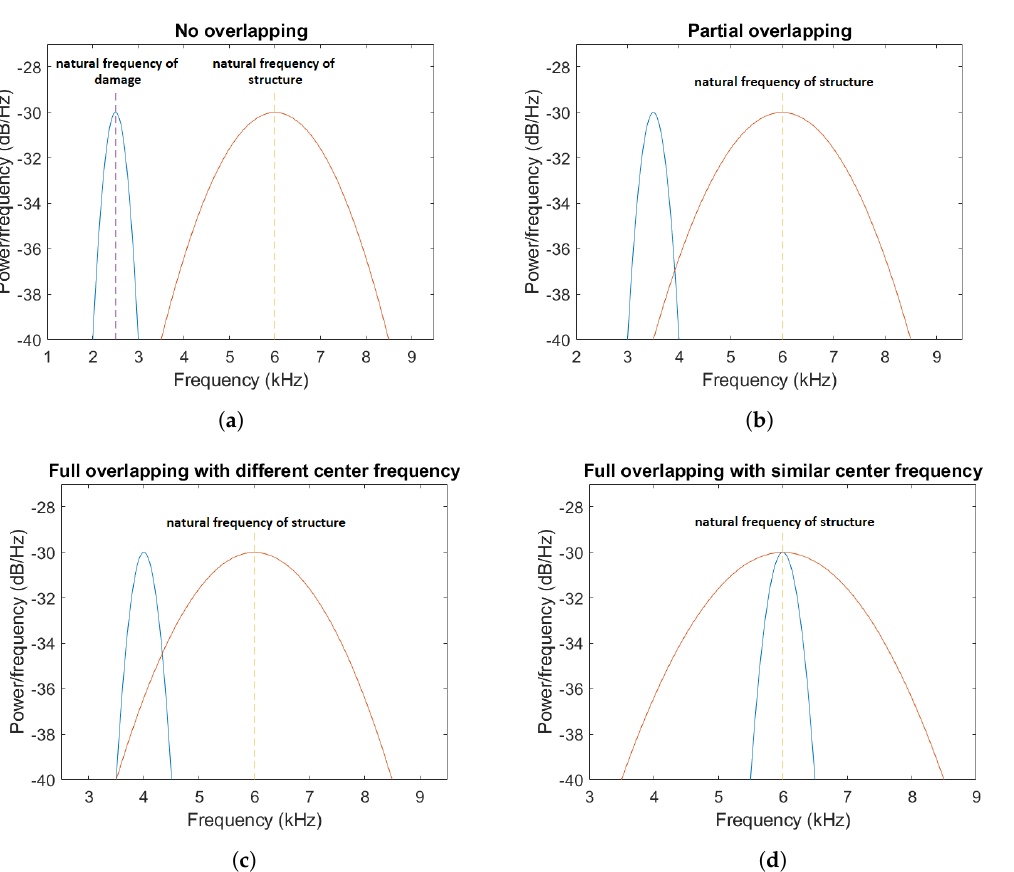
Figure 1. Different cases of the center frequency of a local fault placement with no overlapping frequency bands of cyclic and non-cyclic impulses ( a ), partial overlapping ( b ), and full overlapping ( c , d